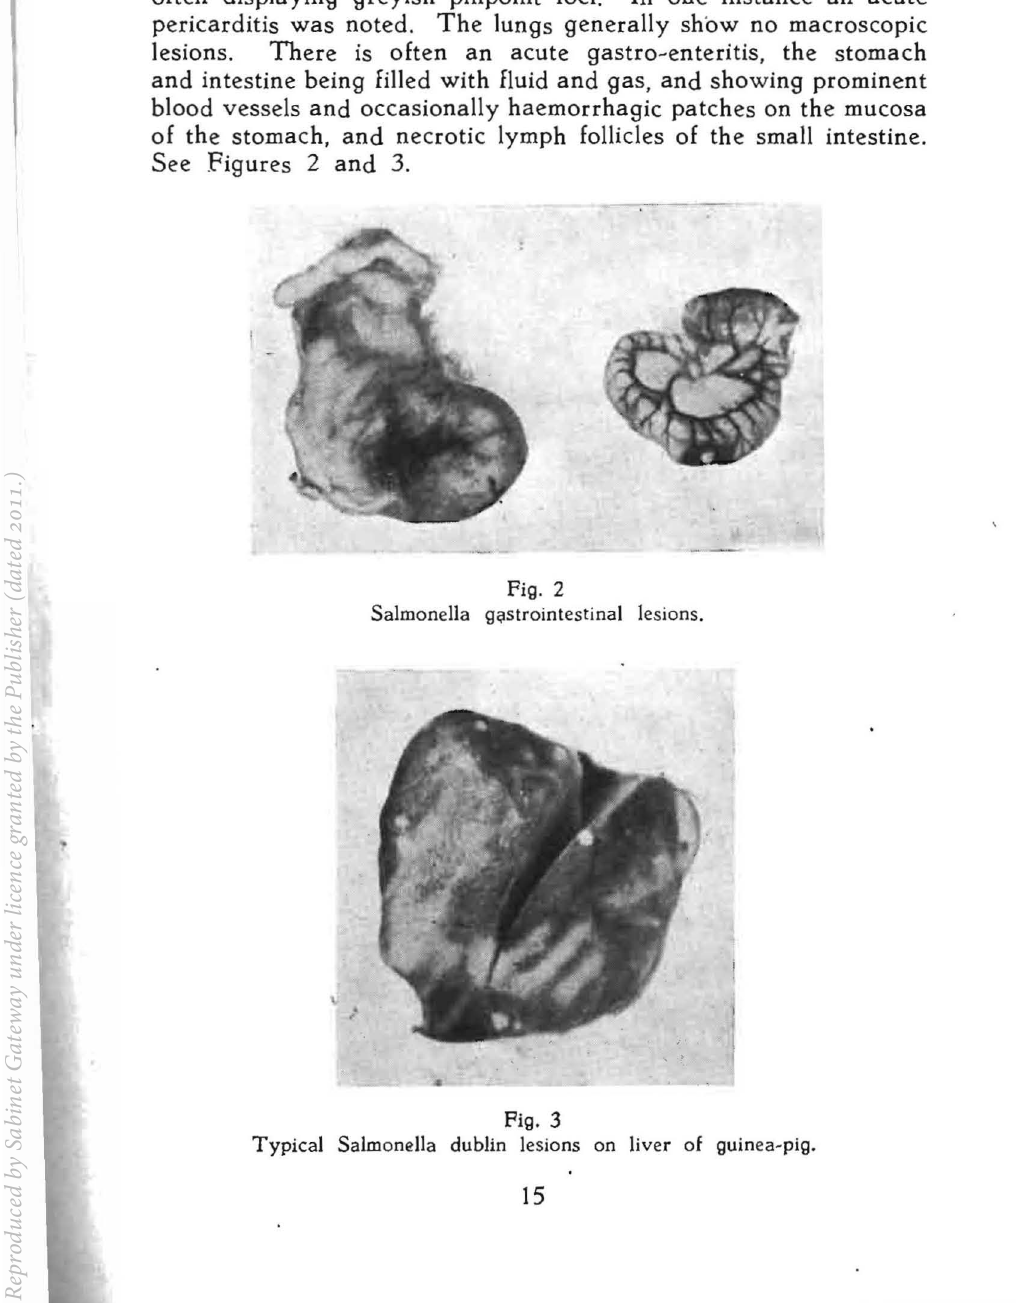
Fig. 3 Typical Salmonella dublin lesions on liver of